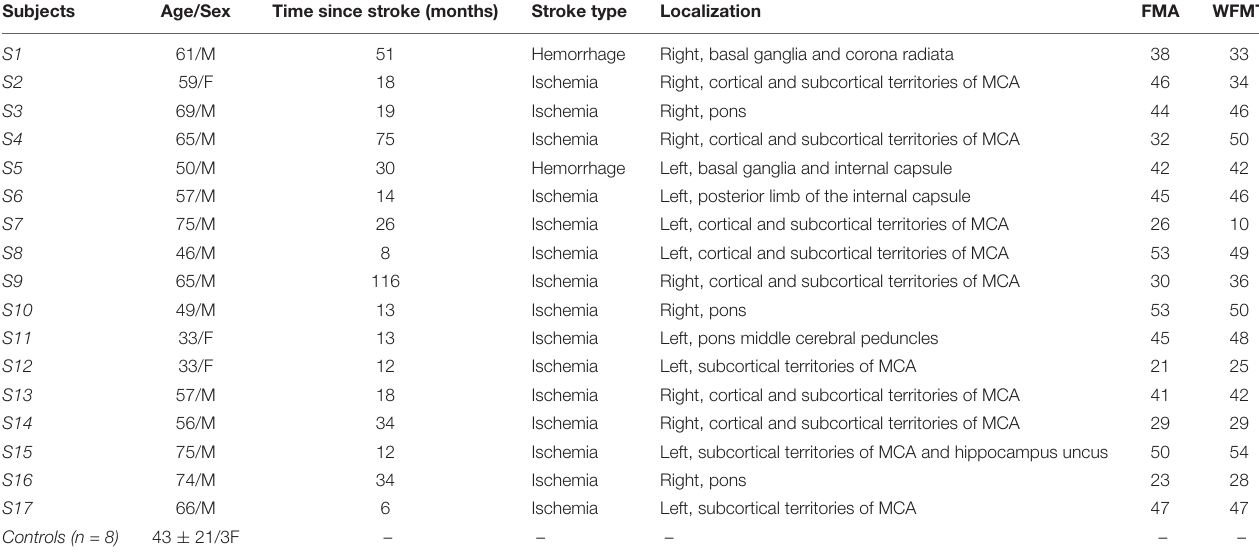
TABLE 1 | Participants’ demographics (M, Male; F, Female; FMA, Fugl-Meyer Assessment for upper extremity; WFMT, Wolf Function Motor Test; MCA, Middle Cerebral